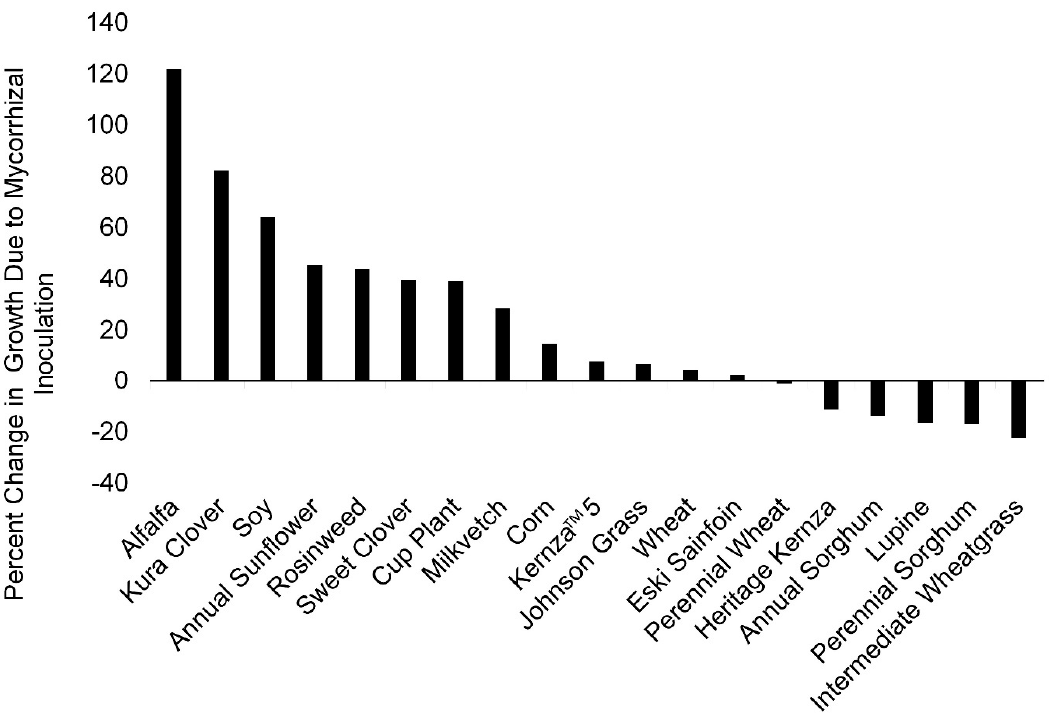
Figure 1. The mycorrhizal responsiveness of each of the 19 plant species in the greenhouse study. The growth of many legumes, composites, and some grasses was improved by as much at 120% with inoculation, while some grass species, including many C3 grasses, were unaffected or even inhibited by as much at 17% with mycorrhizal inoculation. Mycorrhizal responsive is a ratio of plant mass when inoculated with arbuscular mycorrhizal (AM) fungi/grown in sterile soil as calculated from the least squared means from our generalized linear model. Bars represent ((mycorrhizal response × 100) − 100).